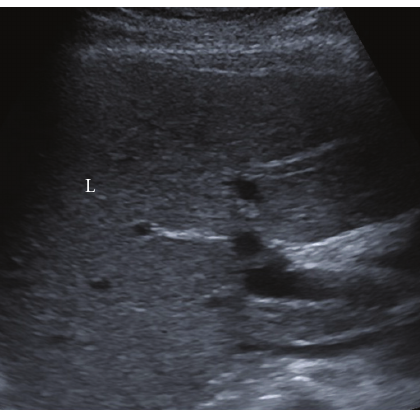
Figure 1: Ultrasonographic image of liver (L). No prominent lesion could be demonstrated.